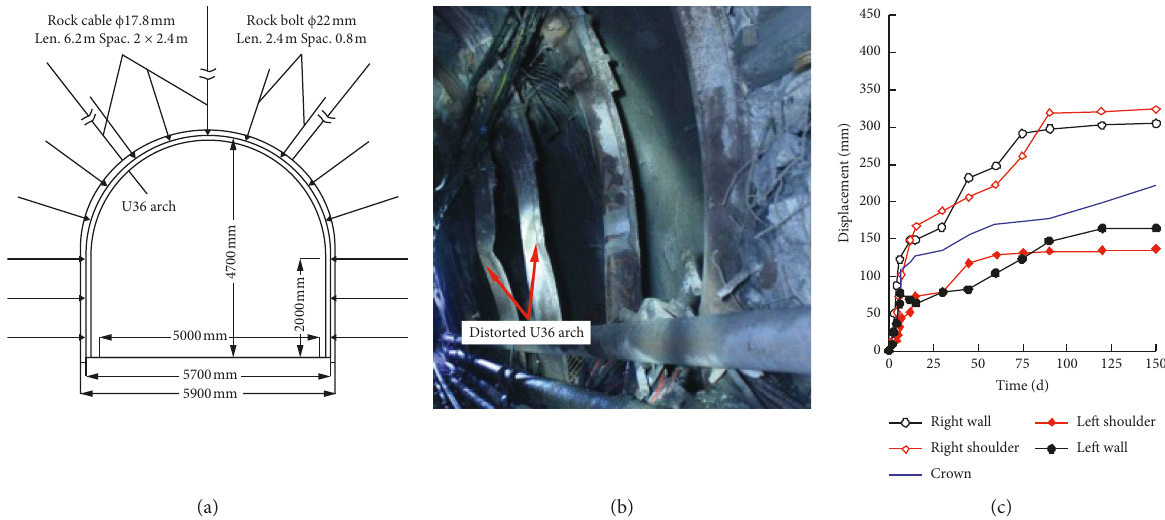
Figure 16: The original support scheme and effect. (a) Original support scheme with U36 steel arch. (b) Distorted U36 arch. (c) Monitoring curves of the roadway under the original scheme.